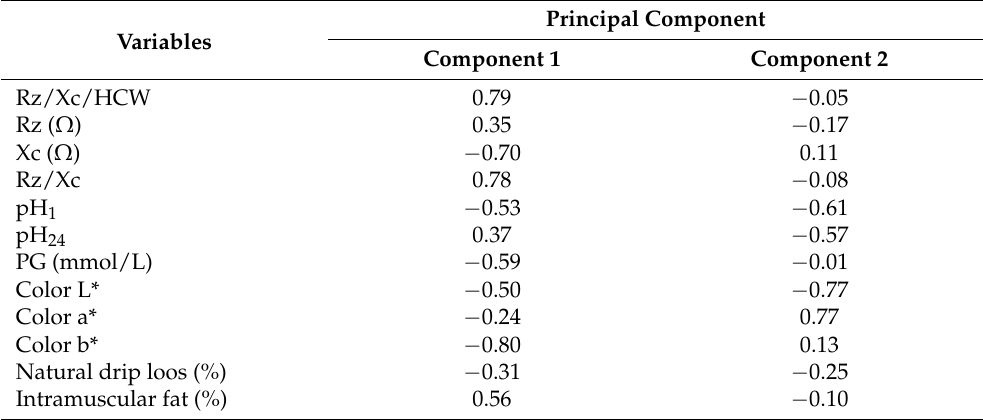
Table 3. Factor coordinates of variables with respect to principal components based on correlation.